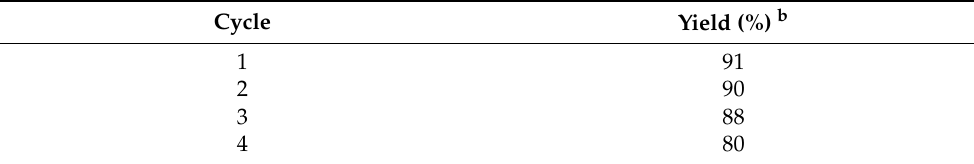
Table 5. Catalyst recycling a Table 5. Catalyst recycling a . Table 5. Catalyst recycling a . Table 5. Catalyst recycling a . Table 5. Catalyst recycling a . Table 5. Catalyst recycling a . Table 5. Catalyst recycling a .